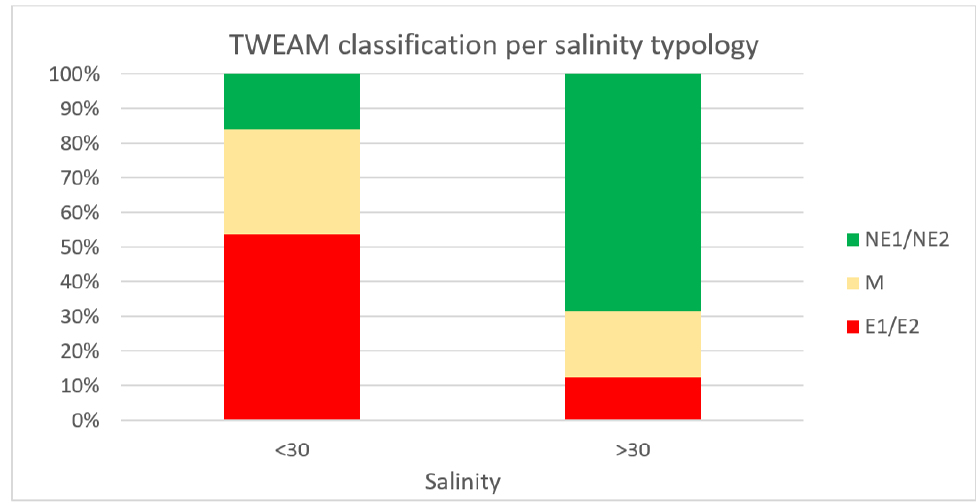
Figure 8. TWEAM classification according to the salinity typology of the sampled stations. By integrating salinity and tidal regime, the stations were grouped into four main types (NT > 30; MT > 30; NT < 30; and MT < 30), and a PCA was applied to investigate the factors that mainly affect the variance of each group (Figure 9). The first (PC1) and second (PC2) components of the PCA explained together 75.9% of the total variance. PC1 was mainly associated with MaQI, TWQI and, to a minor extent, nutrient concentrations of phase 1 (DIN, P-PO 4 ). The PC2 was associated to DIN and P-PO 4